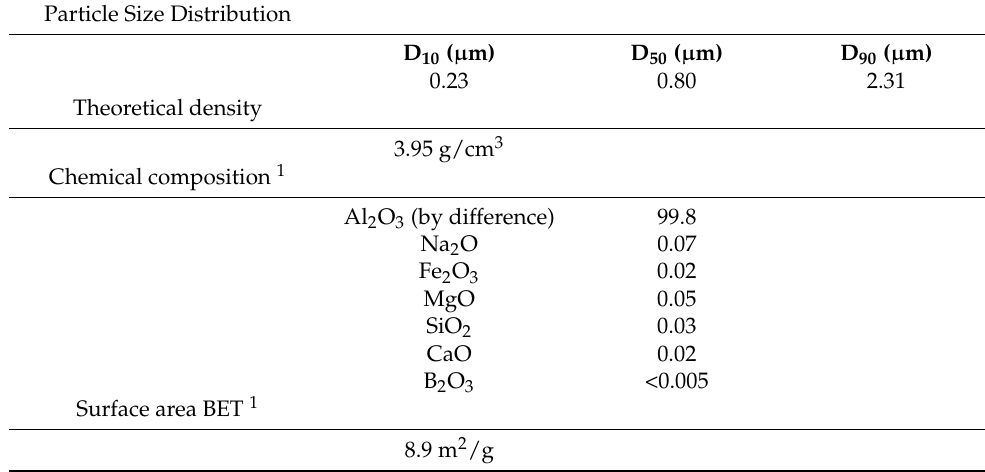
Table 3. Properties of the Al 2 O 3